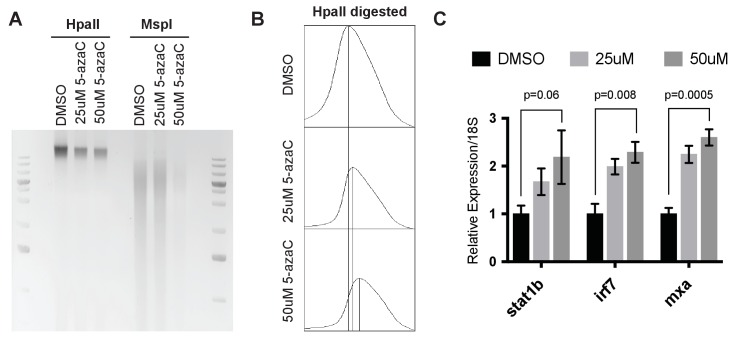
Activation of interferon stimulated genes upon treating zebrafish embryos with 5aza-cytidine.(A) Genomic DNA collected at 24hpf from 5azaC treated zebrafish embryos was digested with HpaII or MspI and run on 1% ethidium bromide gel. Shift in higher molecular-weight band in 5azaC treated embryos upon HpaII digestion indicates DNA hypomethylation. (B) Shift in higher molecular-weight band in 5azaC treated embryos upon HpaII digestion is quantified using ImageJ. (C) qRT-PCR analysis of stat1b, irf7 and mxa expression in 5azaC treated zebrafish embryos at 24 hpf. Error bars indicate SEM from at least three biological replicates with n = 20 embryos for each biological replicate.